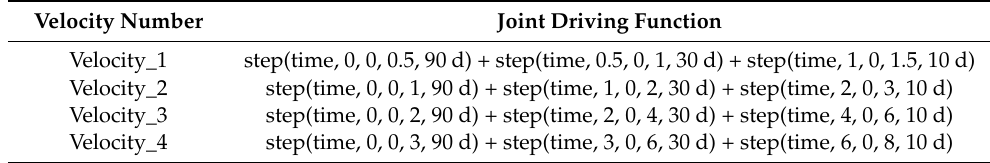
Table 2. Joint speed driving